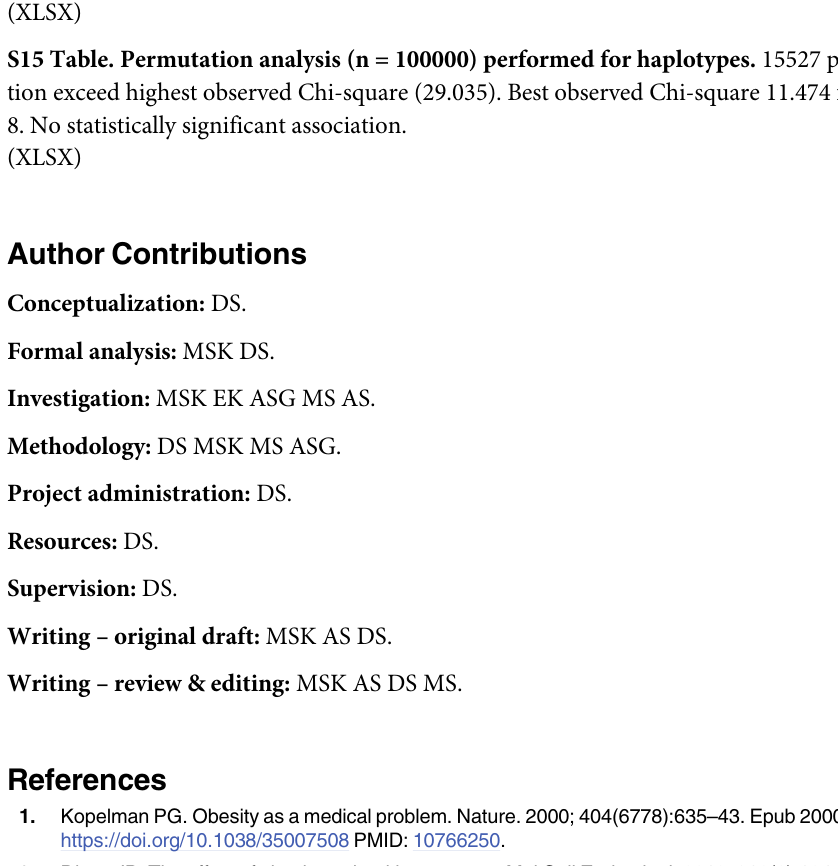
allele. Bold font denotes markers with statistically significant p values. S13 Table. Linear regression analysis of 262 SNPs in Polish population, adjusted for sex and age under additive model. SNP—rs number of tested SNP; BP—Physical position of SNP on chromosome 16; A—minor allele; NMISS—Number of non-missing individuals included in analysis; BETA—regression coefficient; SE—standard error of regression coefficient; L95— Lower bound of 95% confidence interval; U95—Upper bound of 95% confidence interval; STAT—Coefficient t-statistic; P—Asymptotic p-value for t-statistic, bold font denotes markers with statistically significant p values and shaded cells indicate the meaning the additive effects of allele dosage when assuming age and sex as a covariates. S14 Table. Permutation analysis (n = 100000) performed for single markers. 1850 permuta- tion exceed highest observed Chi-square (29.95). Best observed Chi-square 15.355 for rs1558902. Bold font denotes markers with statistically significant p values. S15 Table. Permutation analysis (n = 100000) performed for haplotypes. 15527 permuta- tion exceed highest observed Chi-square (29.035). Best observed Chi-square 11.474 for Block 8. No statistically significant